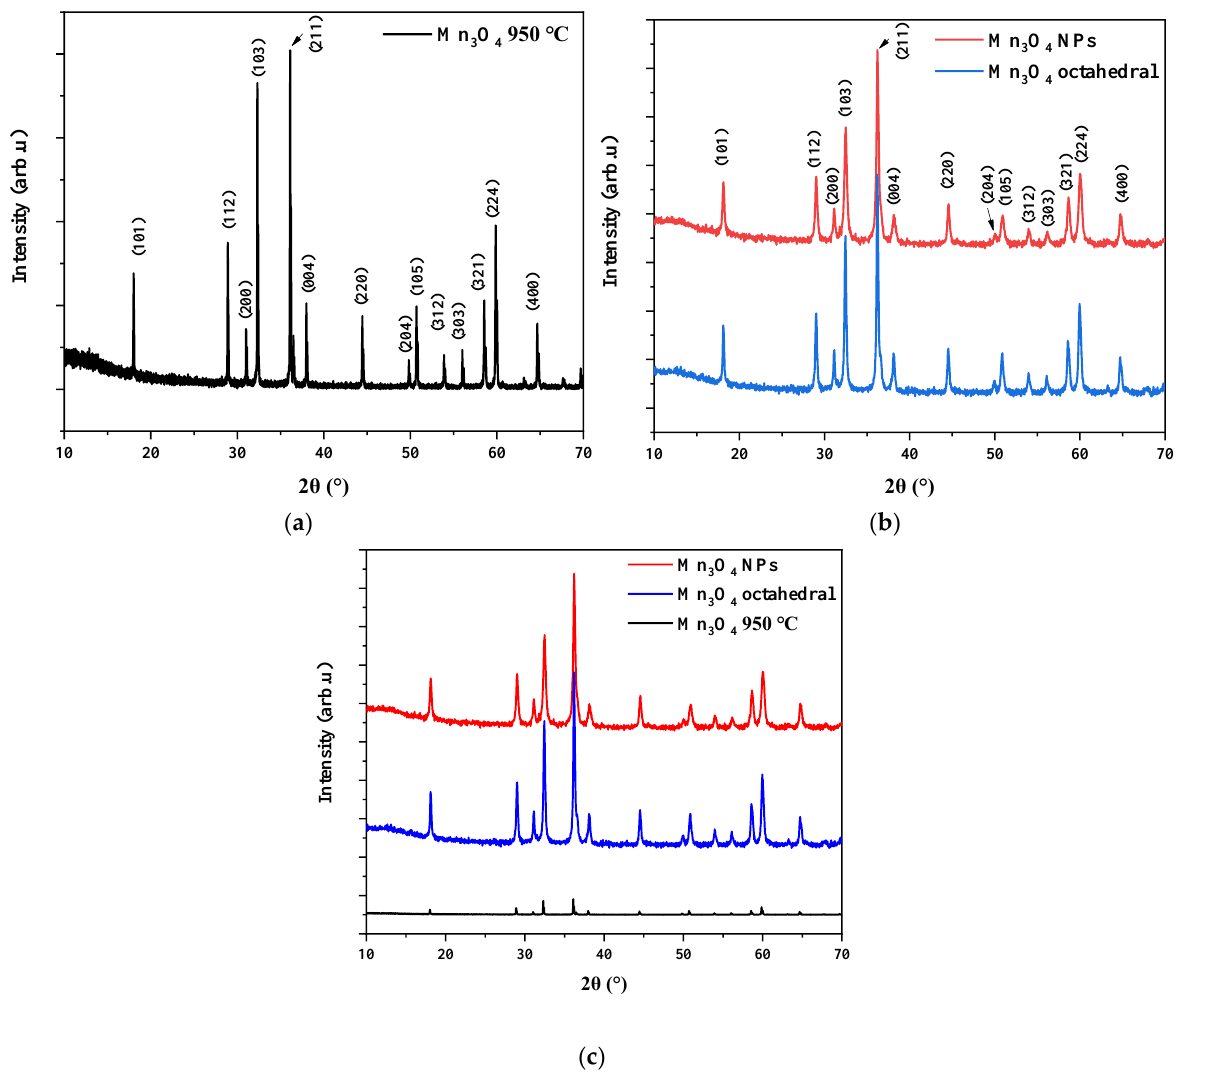
Figure 2. XRD pattern of ( a ) Mn 3 O 4 950 °C ( b ) Mn 3 O 4 NPs and octahedral Mn 3 O 4 , ( c ) combined XRD pattern of as-prepared Mn 3 O 4 samples.